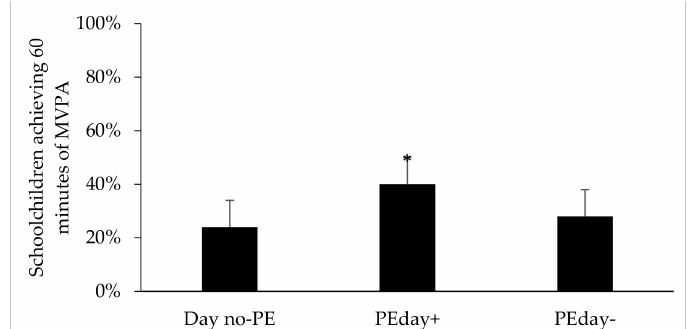
Figure 3. The percentages of schoolchildren who met the recommended duration of daily MVPA (i.e., 60 minutes) on Day no-PE, PEday + , and PEday − . * Significant di ff erences to Day no-PE ( p = 0.005) and PEday- ( p <